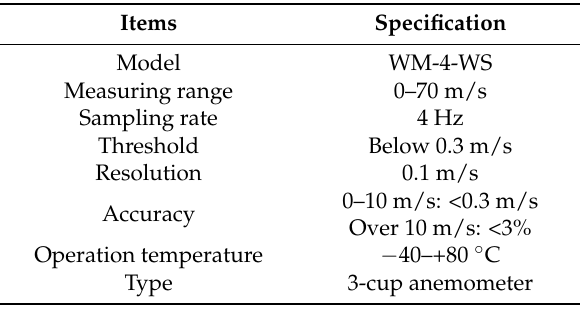
Table 2. Anemometer